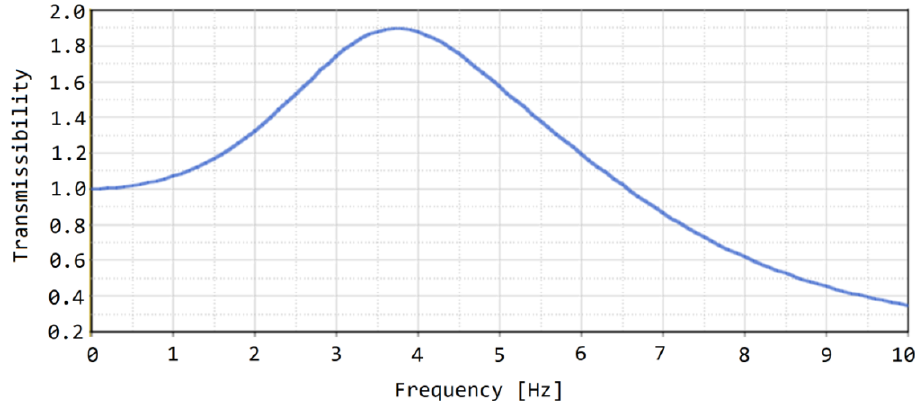
Figure 7. Transmisibility in point 1 of the platform excited with a harmonic vibration in the vertical direction.